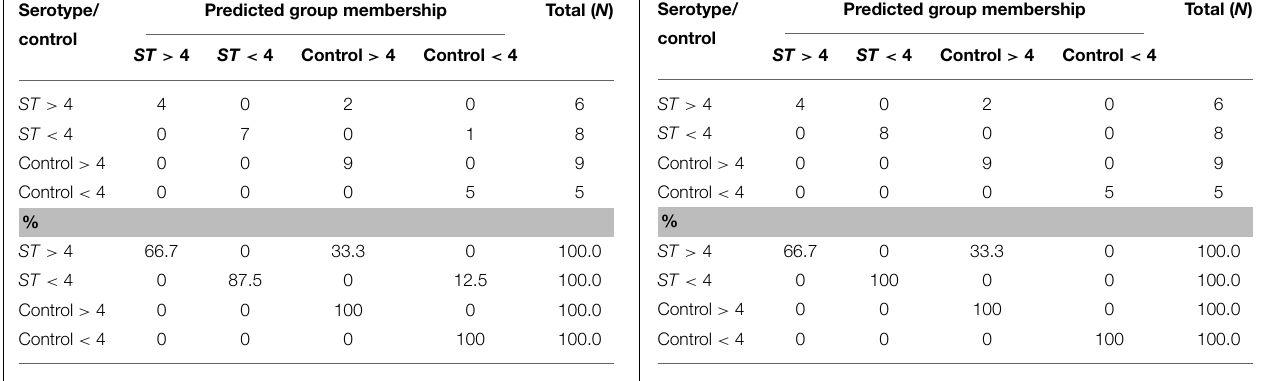
FIGURE 3 | DA models generated with predictor variables: counts of (i) Salmonella , (ii) E. coli , (iii) lactose-negative Enterobacteriaceae , (iv) Bifidobacterium spp., (v) Lactobacillus spp., (vi) Enterococcus spp.,